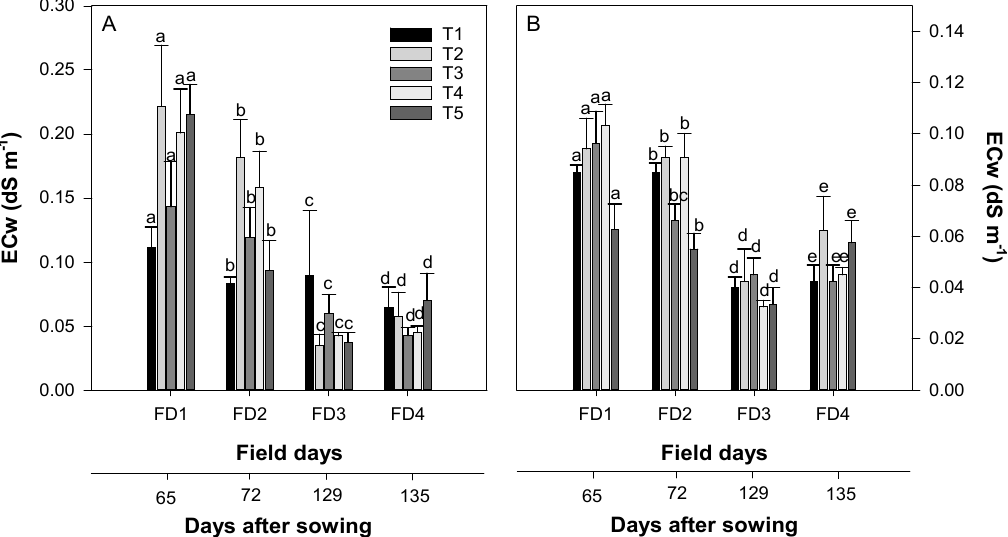
Figure 7. Effect of different soil amendments on temporal variations in electrical conductivity of soil solution at 0–10 cm ( A ) and 10–20 cm ( B ) sowing depth in podzolic soils under various nutrient management practices. Each vertical bar represents mean whereas bar errors show ± standard error for three replications. Lettering is independent of each other.